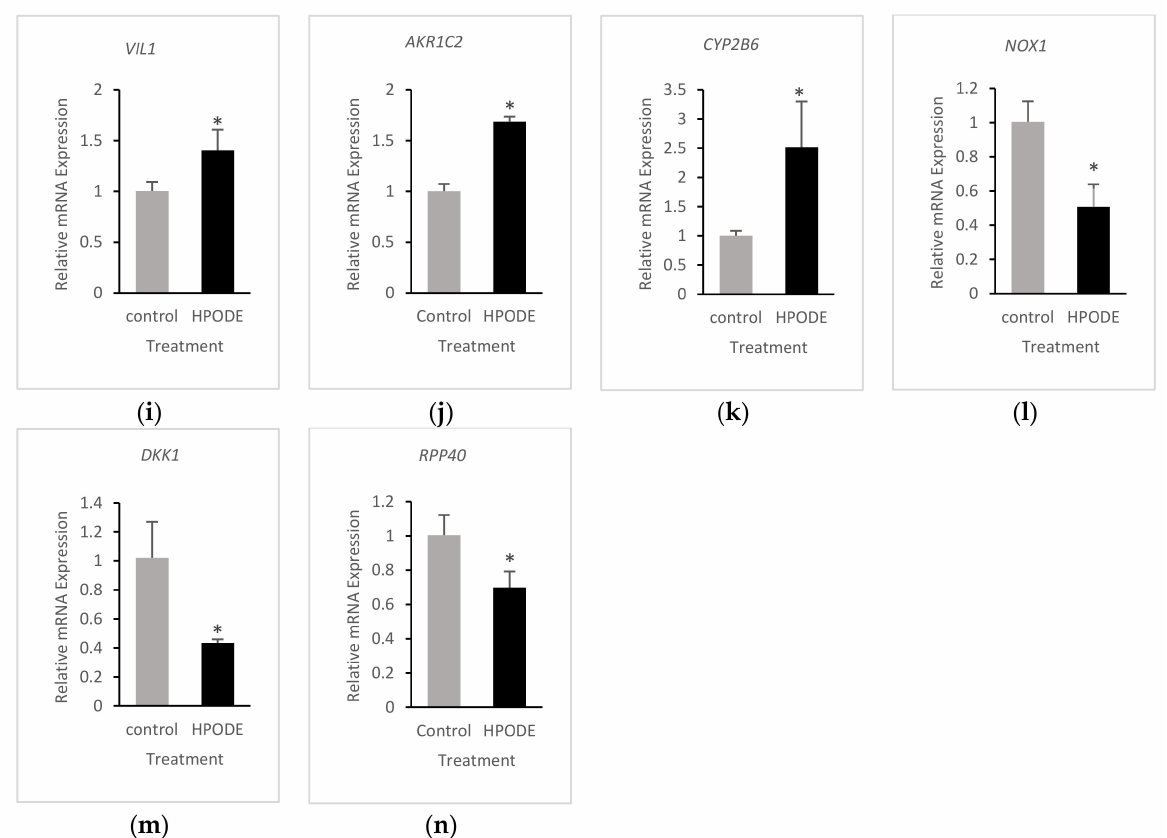
Figure 5. Quantitative Real-time PCR validation of RNA-seq results in 13-HPODE-treated cells ( a – n ). qRT-PCR of representative DEGs from RNA-seq data. Relative mRNA expression of genes is presented in 13-HPODE-treated (HPODE) Caco-2 cells with statistical significance of * p < 0.05 compared to untreated (control) cells. Results were normalized to GAPDH. The relative expression of PCK1 and DKK1 in LA-treated cells was similar to that of